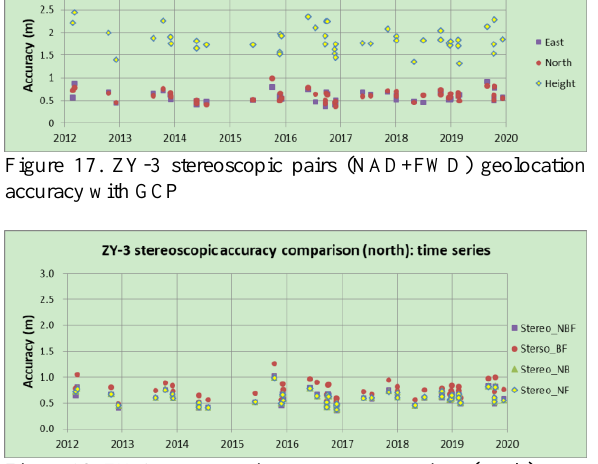
Figure 18. ZY-3 stereoscopic accuracy comparison (north) Num=47